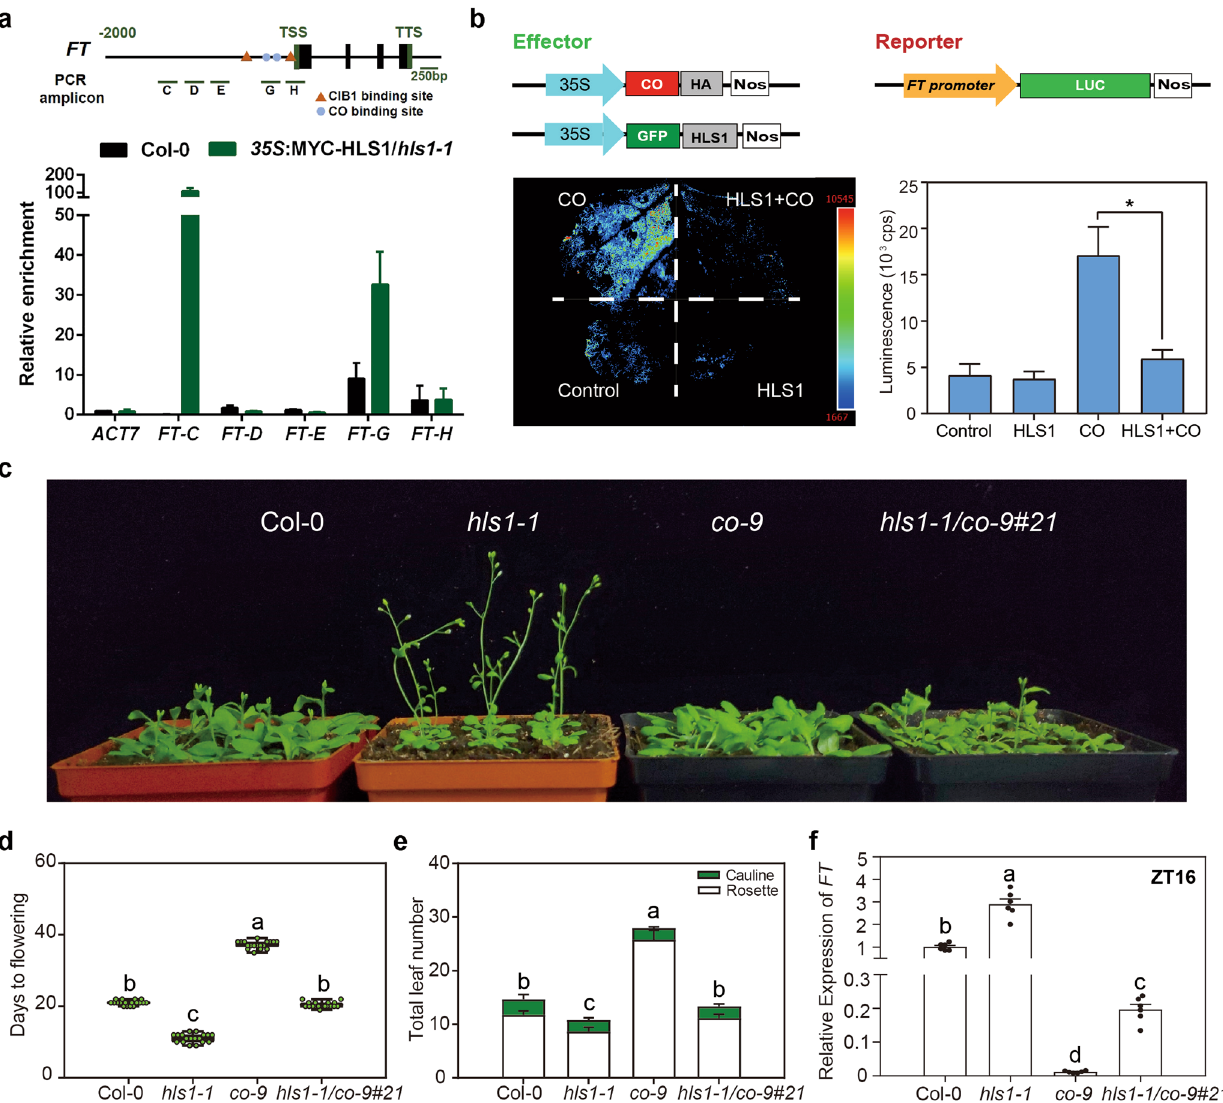
Fig. 5 HLS1 abrogates CO transcriptional activity. a ChIP-PCR assays examining the DNA-binding ability of HLS1. Cross-linked chromatin extracted from 35S :MYC-HLS1/ hls1-1 plants was precipitated with anti-MYC antibody, and the eluted DNA was used to amplify different areas of the FT promoter by qPCR. Col-0 plants were used as negative controls. Values shown are means± SD; n = 3. TSS: transcription start site; TTS: transcription terminal site. b Transient transcriptional regulation of FT promoter activity. A. tumefaciens cells harboring pFT :LUC (reporter) were co-in fi ltrated with different effectors into N. benthamiana leaves. LUC activity was detected at 3 days after in fi ltration. Representative in fi ltrated N. benthamiana leaf image detected under CCD camera were shown on the left side. Quantitative results (right side) showing luminescence signal counts per second (cps) in each in fi ltrated region. Signi fi cant differences were determined by one-way analysis of variance (ANOVA) and post hoc Tukey ’ s test, data are means ± SD; n = 3, * P < 0.05. c Representative image showing 24-day-old plants grown under LD conditions. d Statistical analysis of the days from germination to fl owering under LD conditions. Signi fi cant differences were determined by one-way analysis of variance (ANOVA) and post hoc Tukey ’ s test, with different lowercase letters indicating signi fi cant differences (Data are means ± SD; n = 18, P < 0.05). e Statistical analysis of the total leaf number under LD conditions. Signi fi cant differences were determined by two-way analysis of variance (ANOVA) and post hoc Tukey ’ s test, with different lowercase letters indicating signi fi cant differences (Data are means ± SD; n = 18, P < 0.05). f Expression levels of FT in 7-day-old plants grown under LD conditions at ZT16. Signi fi cant differences were determined by one-way analysis of variance (ANOVA) and post hoc Tukey ’ s test, with different lowercase letters indicating signi fi cant differences (Data are means ± SD; n = 6, P <